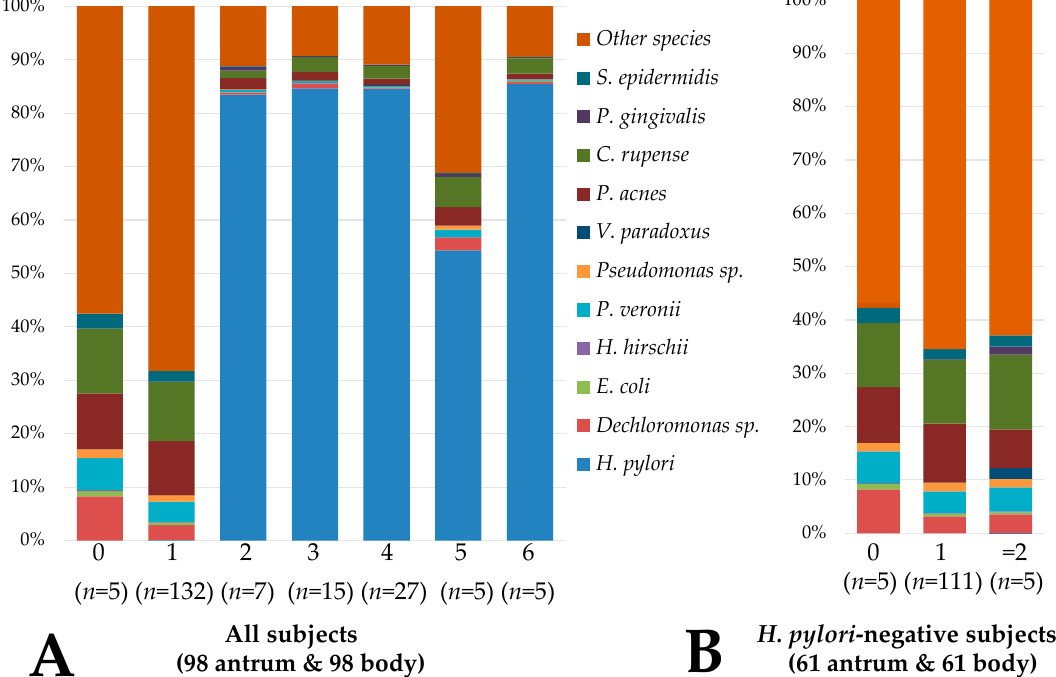
Figure 2. Composition of the gastric microbiota according to the combined inflammation score of neutrophil and mononuclear cell infiltration. ( A ) The composition of the gastric microbiota is shown according to the combined inflammation score. Scores of 0, 1, 2, and 3 indicate no, mild, moderate, and marked degrees, respectively, of neutrophil or mononuclear cell infiltration. The composition of gastric microbiota differed between the subjects with a score <2 and those with a score ≥ 2. ( B ) Among the 61 H. pylori -negative subjects, only five subjects had a combined inflammation score ≥ 2. Significant differences were found with the relative abundance of Variovorax paradoxus and Porphyromonas gingivalis between the subjects with scores ≥ 2 and those with scores <2. S. epidermidis: Staphylococcus epidermidis; C. rupense: Cloacibacterium rupense; P. acnes: Propionibacterium acnés; P. veronii: Pseudomonas veronii; H. hirschii; Hydrogenophilus hirschii; E. coli: Escherichia coli. Table 2. Significant correlations between the relative abundance of microbiota and the combined inflammation score.